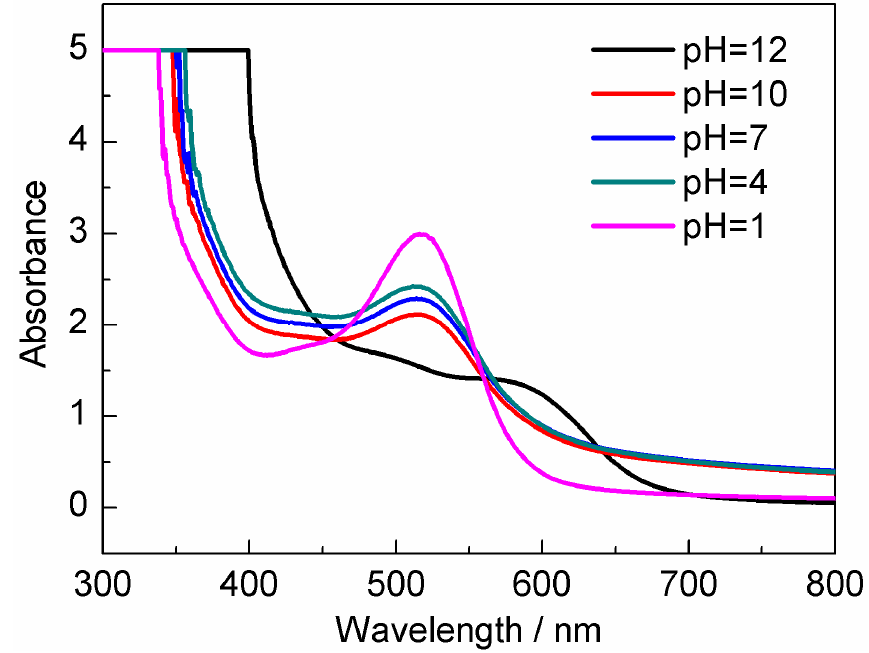
Figure 1. Spectral character of S. chinensis fruit anthocyanin at different pH